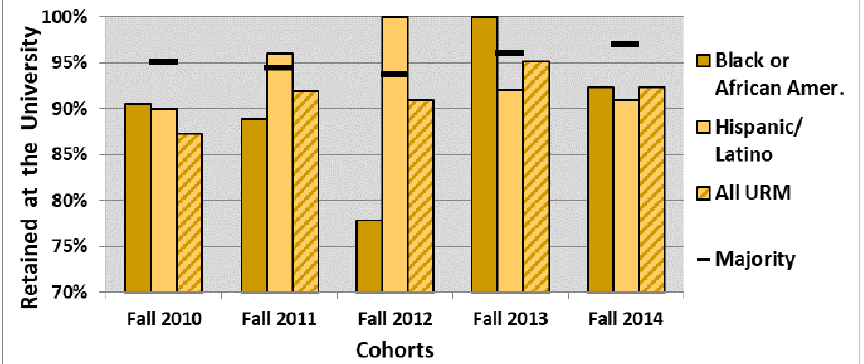
Fig. 2. First year retention for the fall 2010 to fall 2014 cohorts within